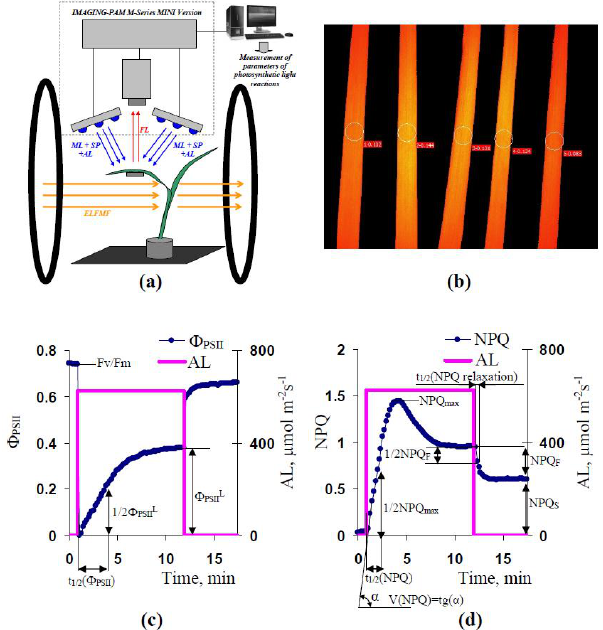
Figure 10. ( a ) Schema of plant localization in experiments with measurements of parameters of photosynthetic light reactions with using IMAGING-PAM M-Series MINI Version under simultaneous treatment by the artificial extremely low-frequency magnetic field (ELFMF). AL is actinic light, ML is measuring light, and SP is saturation pulse. Blue light (450 nm) was used for the illumination of leaves. FL is chlorophyll fluorescence; ( b ) localization of investigated areas (ROIs) at PAM-imaging in wheat leaves; ( c ) change in quantum yield of photosystem II ( Φ PSII ) under AL action and estimation of parameters of this change. F v /F m is the potential quantum yield of photosystem II, Φ PSIIL is the effective quantum yield of photosystem II (PSII) after 10 min of illumination by AL, and t 1/2 ( Φ PSII ) is the time of 50% increase in Φ PSII under illumination; ( d ) change in non-photochemical quenching (NPQ) under the AL action. NPQ F is the fast-relaxing component of NPQ after 10 min of illumination, NPQ S is the slow-relaxing component of NPQ after this illumination, NPQ max is the maximal value of NPQ, t 1/2 (NPQ) is the time of 50% increase in NPQ under illumination, V(NPQ) is the initial linear velocity of the NPQ increase, and t 1/2 (NPQ relaxation) is the time of 50% decrease in NPQ F after the termination of